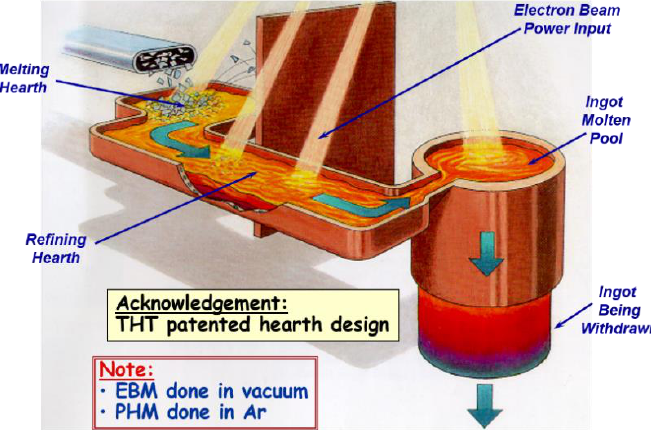
Figure 1. Schematic of a cold hearth melting unit using four electron beam guns as heat sources [2]. Adapted from “Titanium, 2nd edition”, Springer-Verlag, Heidelberg, Germany, 2007.